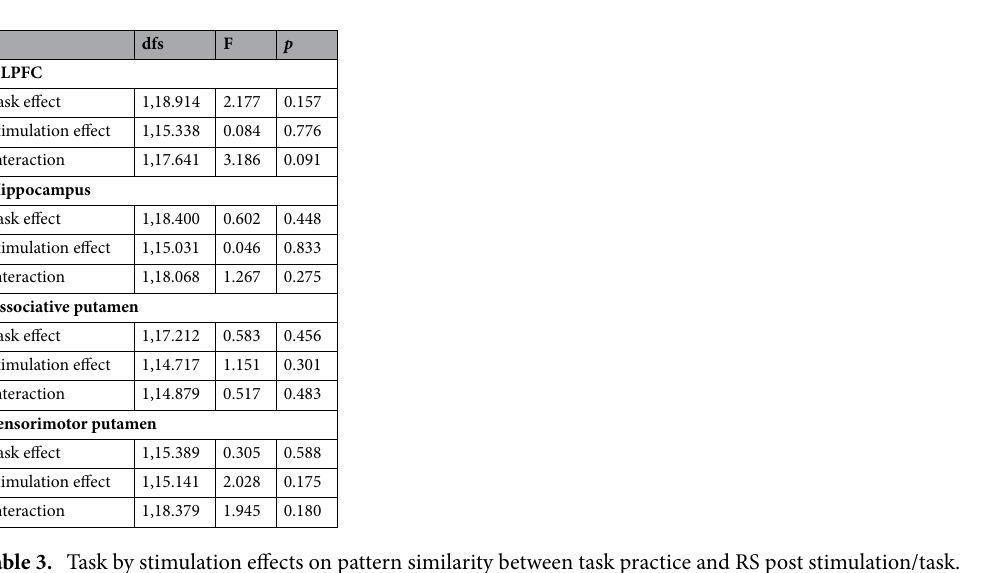
Table 3. Task by stimulation effects on pattern similarity between task practice and RS post stimulation/task. DLPFC - dorsolateral prefrontal cortex, dfs - degrees of